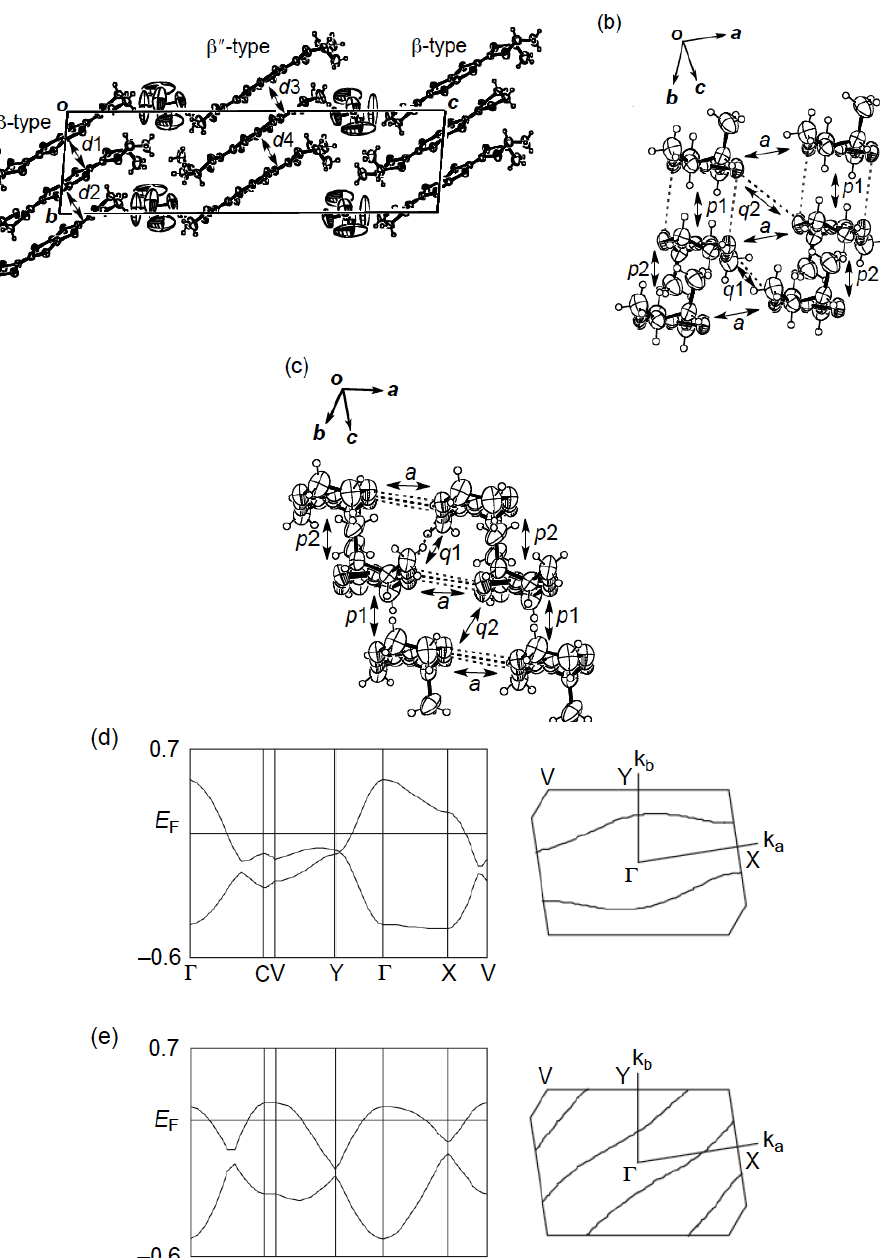
Figure 27. ( a ) Crystal structure of ( meso -DMDH-TTP) AsF . Interplanar distances in the 2 6 β-type and β -type donor layers are 3.61( d 1), 3.78 ( d 2), 3.739 ( d 3) and 3.737 ( d 4) Å, respectively. ( b ) β-Type donor arrangement. Short S···S contacts [3.643(3)–3.710(2) Å] are shown by broken lines. Intermolecular overlap integrals p 1, p 2, a , q 1 and q 2 are 17.4, 11.4, −2.87, 12.0 and 4.43 × 10 −3 , respectively. ( c ) β -Type donor arrangement. Short S···S contacts [3.549(4)–3.708(3) Å] are drawn by broken lines. Intermolecular overlap integrals p 1, p 2, a , q 1 and q 2 are 4.66, 1.69, 3.80, 17.6 and 17.0 × 10 −3 , respectively. ( d ) Band structure and Fermi surface of the β-type donor layer. ( e ) Band structure and Fermi surface of the β -type donor layer (Reprinted with permission from reference 51, The Chemical Society of